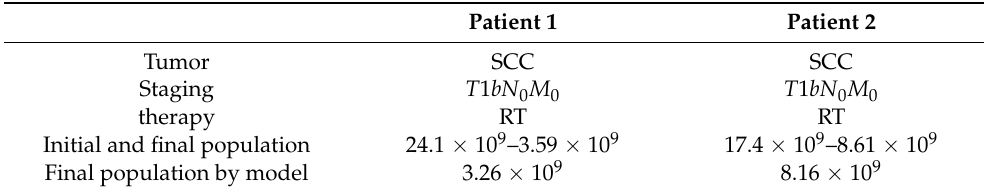
Table 2. Patient data: tumor Type (Squamous Cell Carcinoma, Adenocarcinoma), therapy